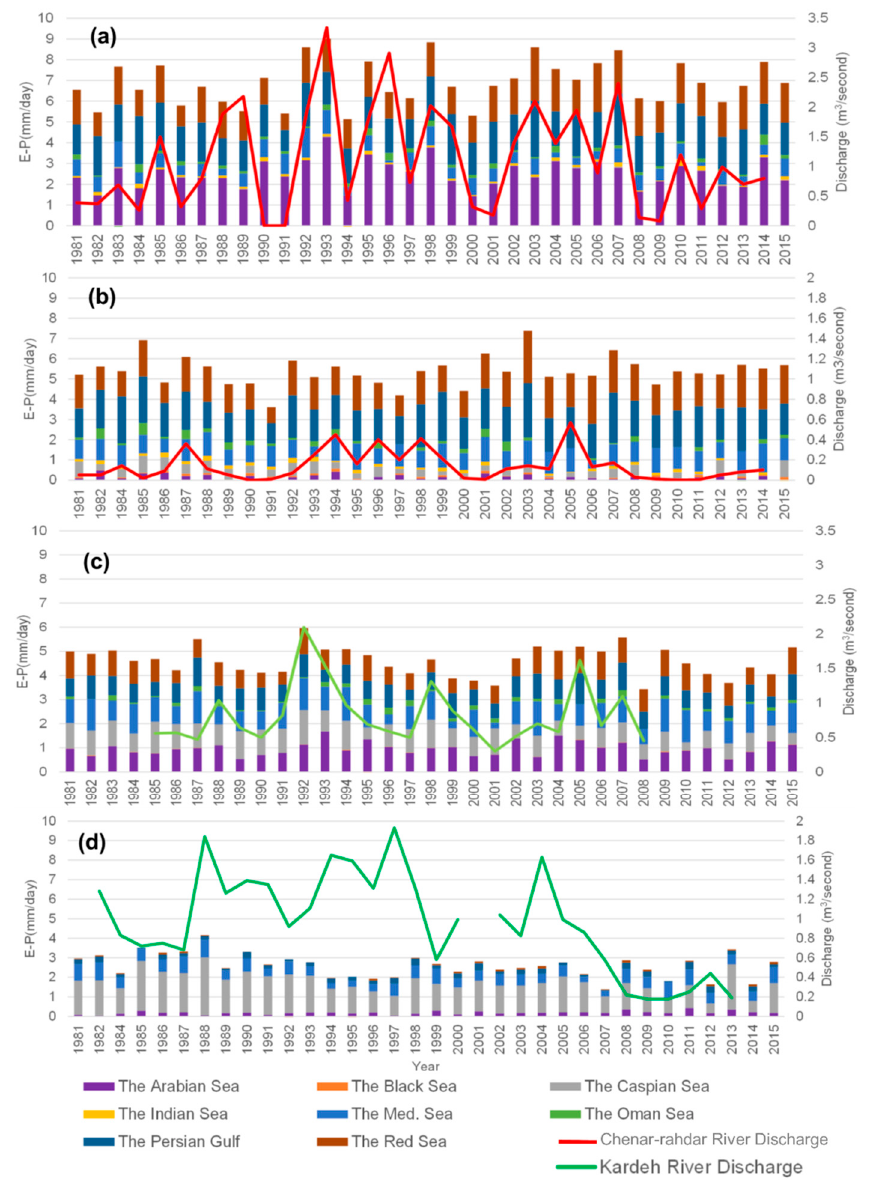
Figure 8. Variations of marine moisture sources ( E − P ) > 0 over the Shiraz box in the wet ( a ) and dry ( b ) periods and over the Mashhad box in the wet ( c ) and dry ( d ) periods.